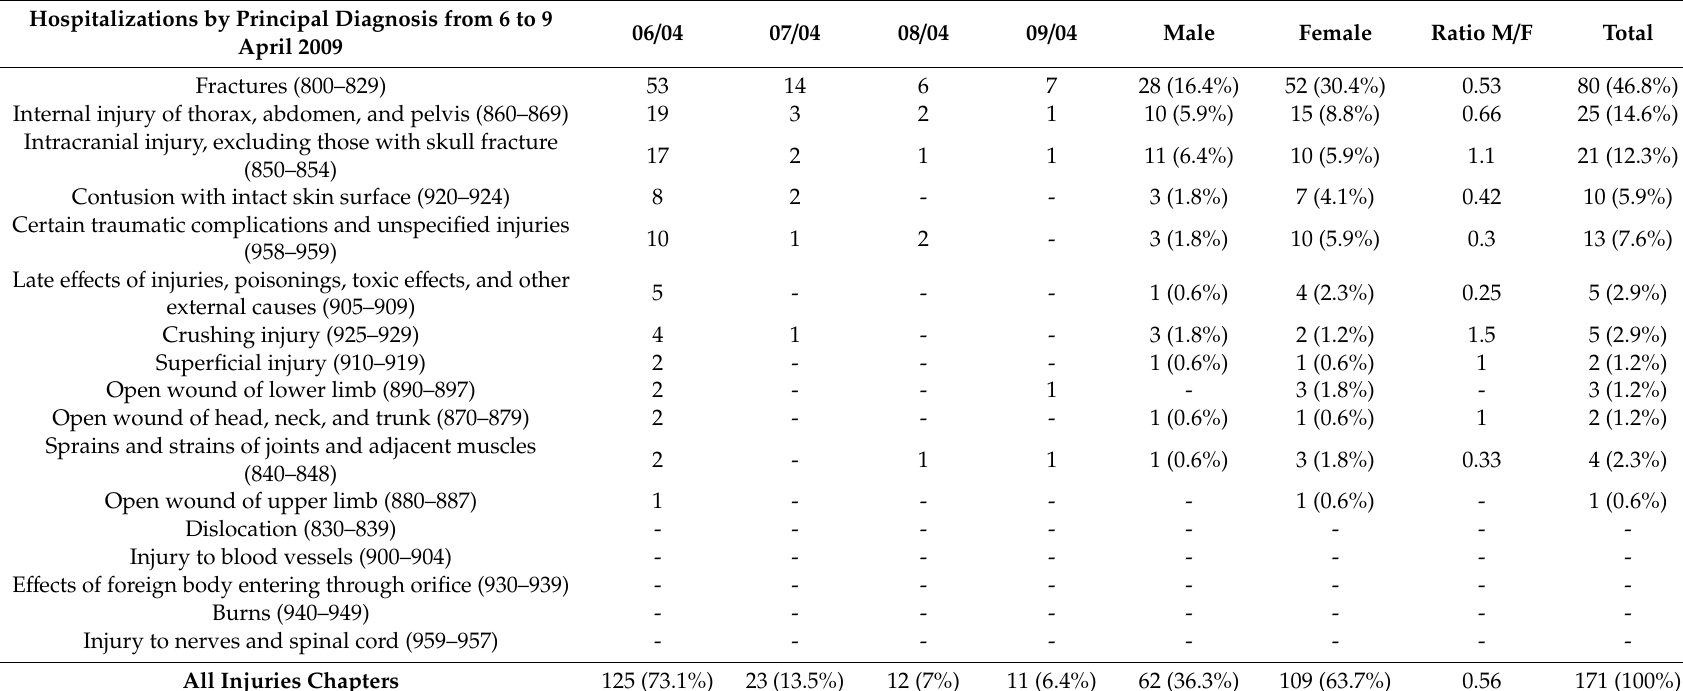
Table 2. Frequencies by date and gender, grouped by injury type (ICD-9-CM, Injury Chapters). Hospitalizations by Principal Diagnosis from 6 to